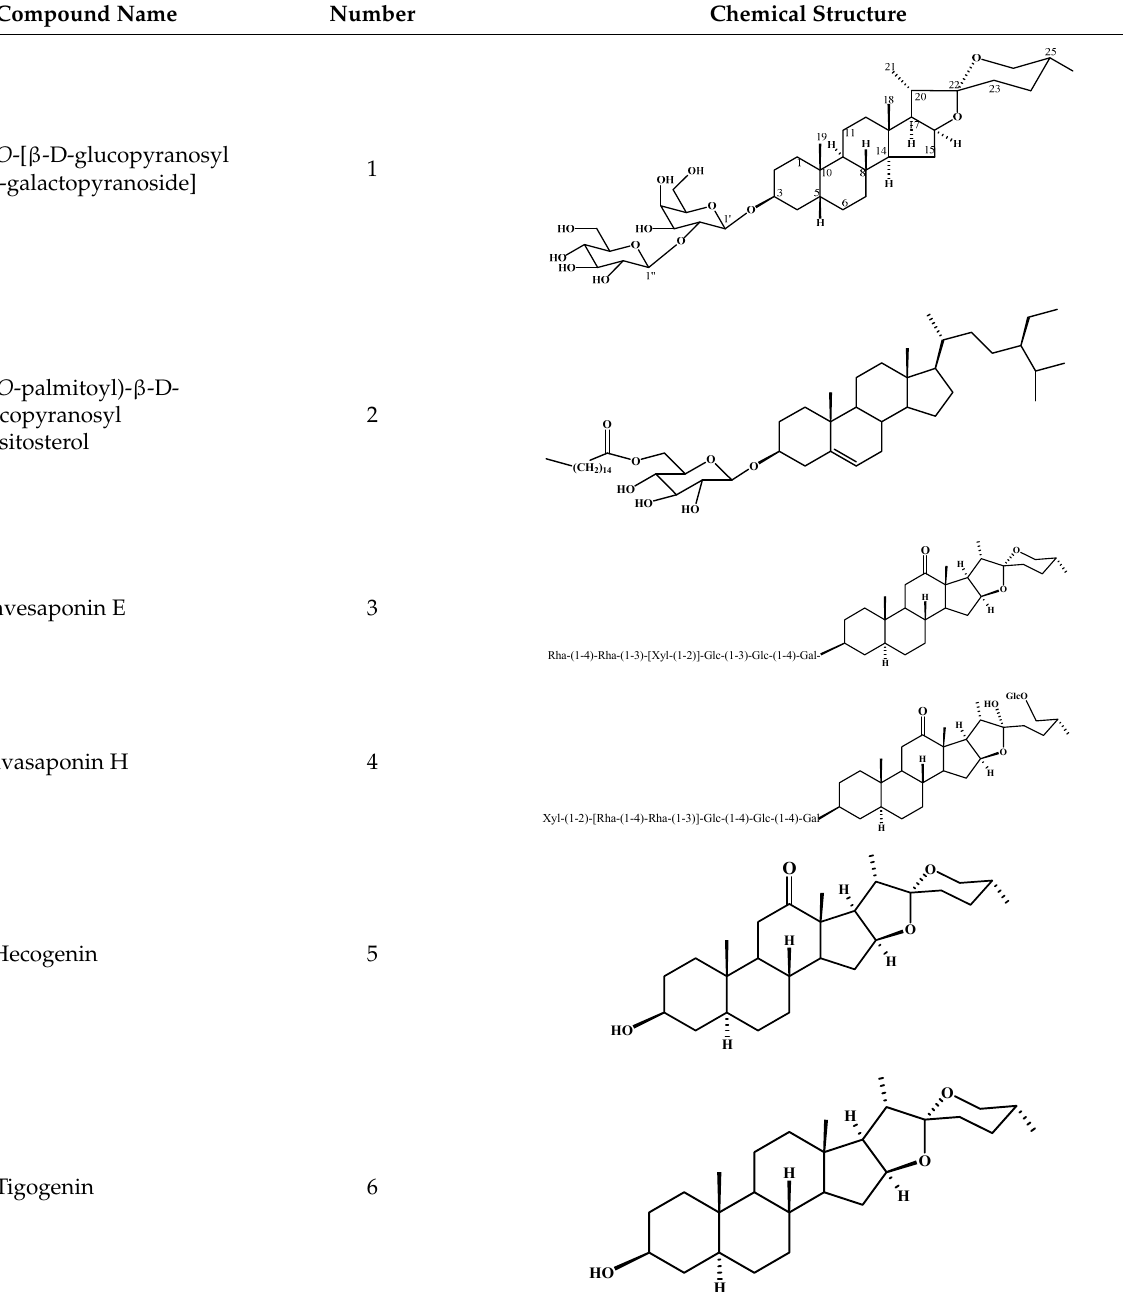
Table 2. Chemical structures of compounds with anti-inflammatory activity contained in Agave species.